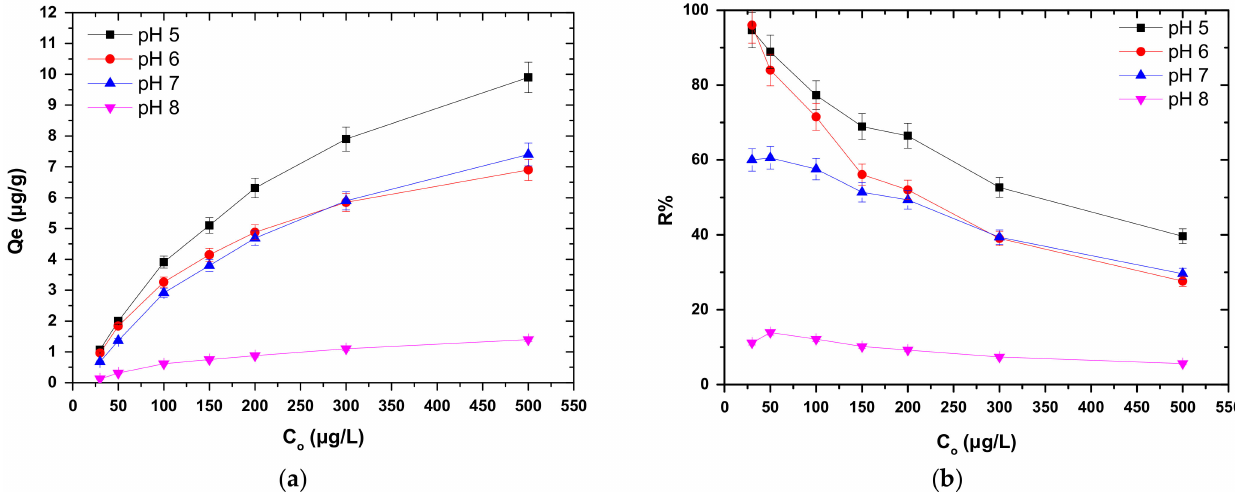
Figure 6. Effect of initial Cr(VI) concentration on the adsorption of Cr(VI) on COC-AC-La; in terms ( a ) of Q e and ( b ) of R % removal; initial Cr(VI) concentration 30–500 µ g/L, solution pH 5–8, dose 0.2 g/L, T = 22 ± 1 ◦ C, contact time 24 h, in deionized